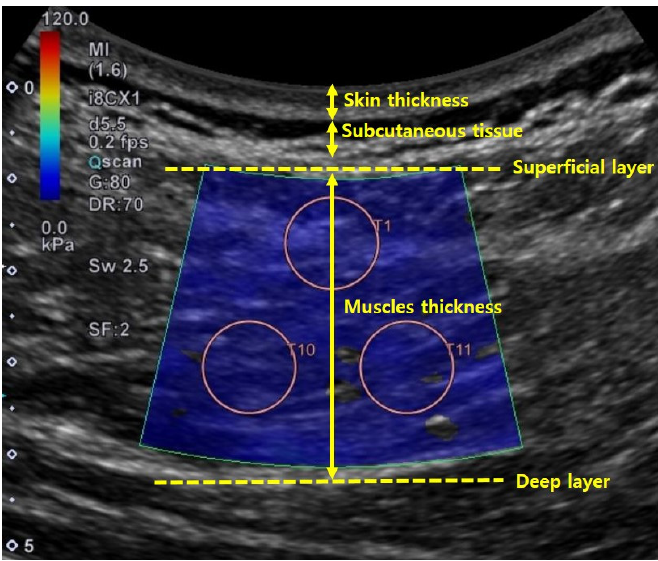
Figure 4. Method used to determine skin and muscle thicknesses in ultrasound